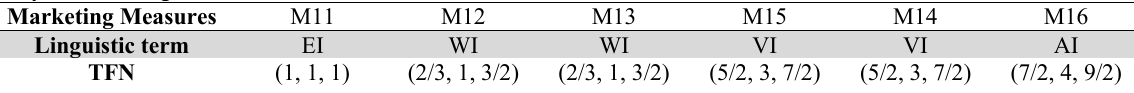
Fuzzy Criterion Significance for the Measures Marketing Measures